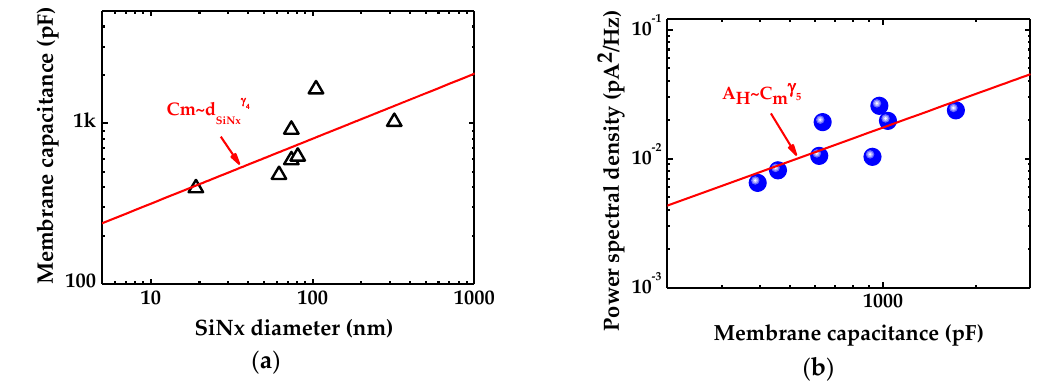
Figure 6. Impact of graphene suspended area on noise in high-frequency region: ( a ) Membrane capacitance measured by membrane test in 2 M KCl solution versus underlying SiN x diameter; and ( b ) the relationship between high-frequency noise and membrane capacitance. The fit line determines a dependency of high-frequency noise on membrane capacitance.